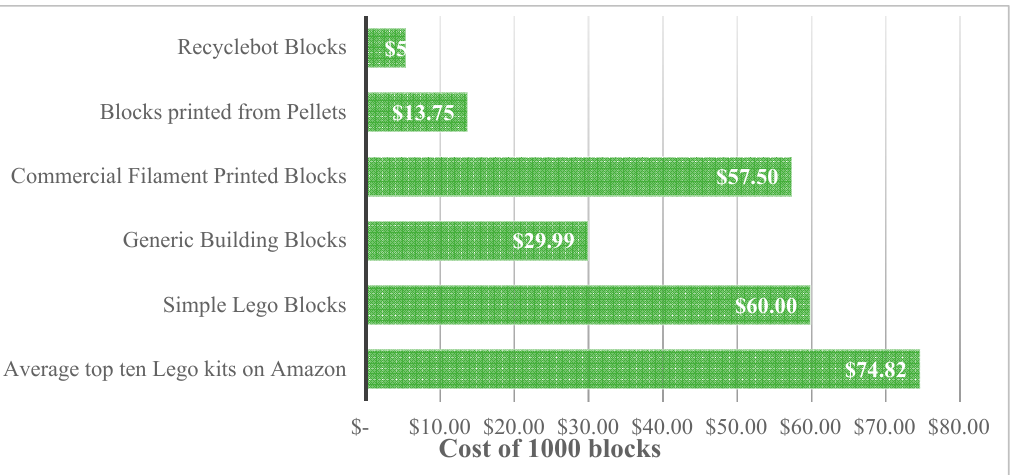
Figure 6. The costs of fabricating 1000 2 × 3 Lego compatible bricks or purchasing.